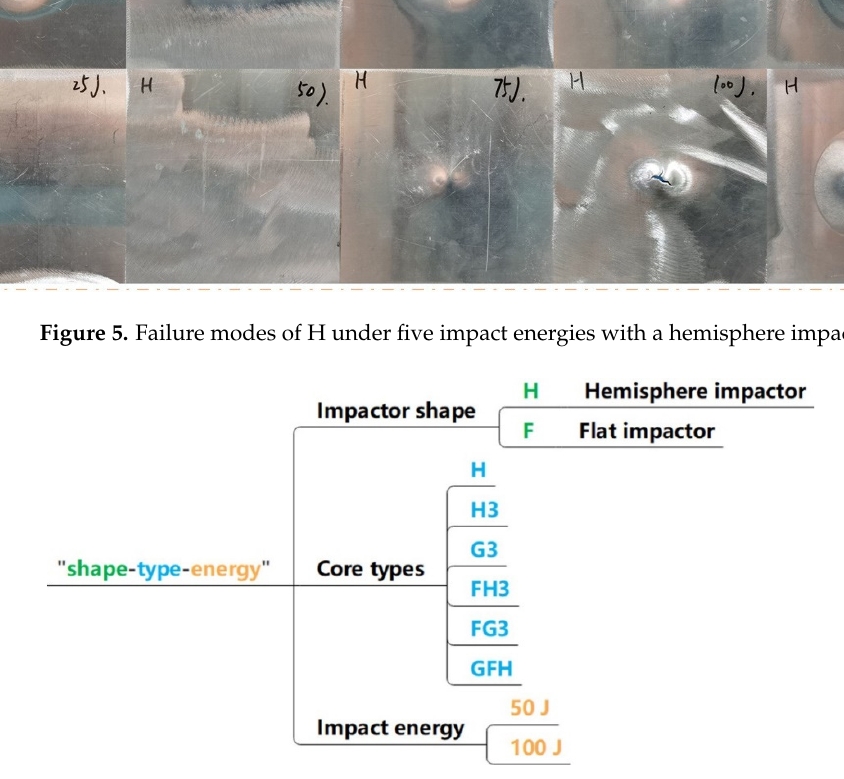
Figure 6. Coding for the sandwich panels.